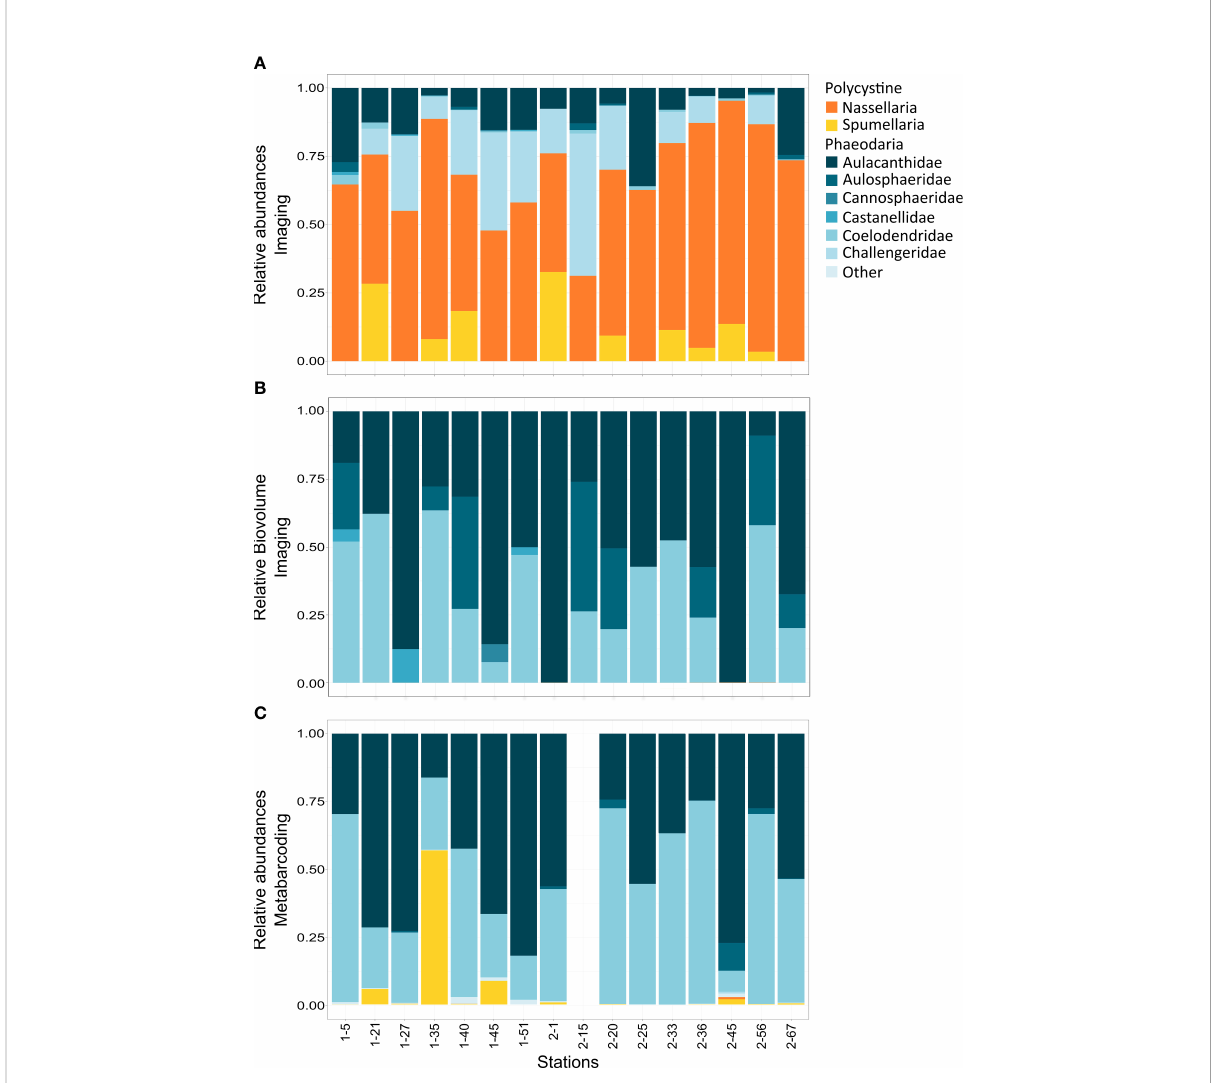
FIGURE 3 (A) Imaging technologies data. Relative abundances of the main rhizarians taxonomic groups cumulated from the different size fractions (> 64-200, 200-1000, > 1000 µm), from data obtained using the FlowCAM, Zooscan and UVP. (B) Imaging technologies data. Relative biovolume of the main rhizarians taxonomic groups cumulated from the different size fractions (> 64-200, 200-1000, > 1000 µm), from data obtained using the FlowCAM, Zooscan and UVP. (C) Molecular metabarcoding data. Relative abundance reads of the main rhizarian taxonomic groups in the different size fractions cumulated (> 64, > 200, > 500µm) of the V4 rDNA from vertical tow nets. No metabarcoding data was available for stations